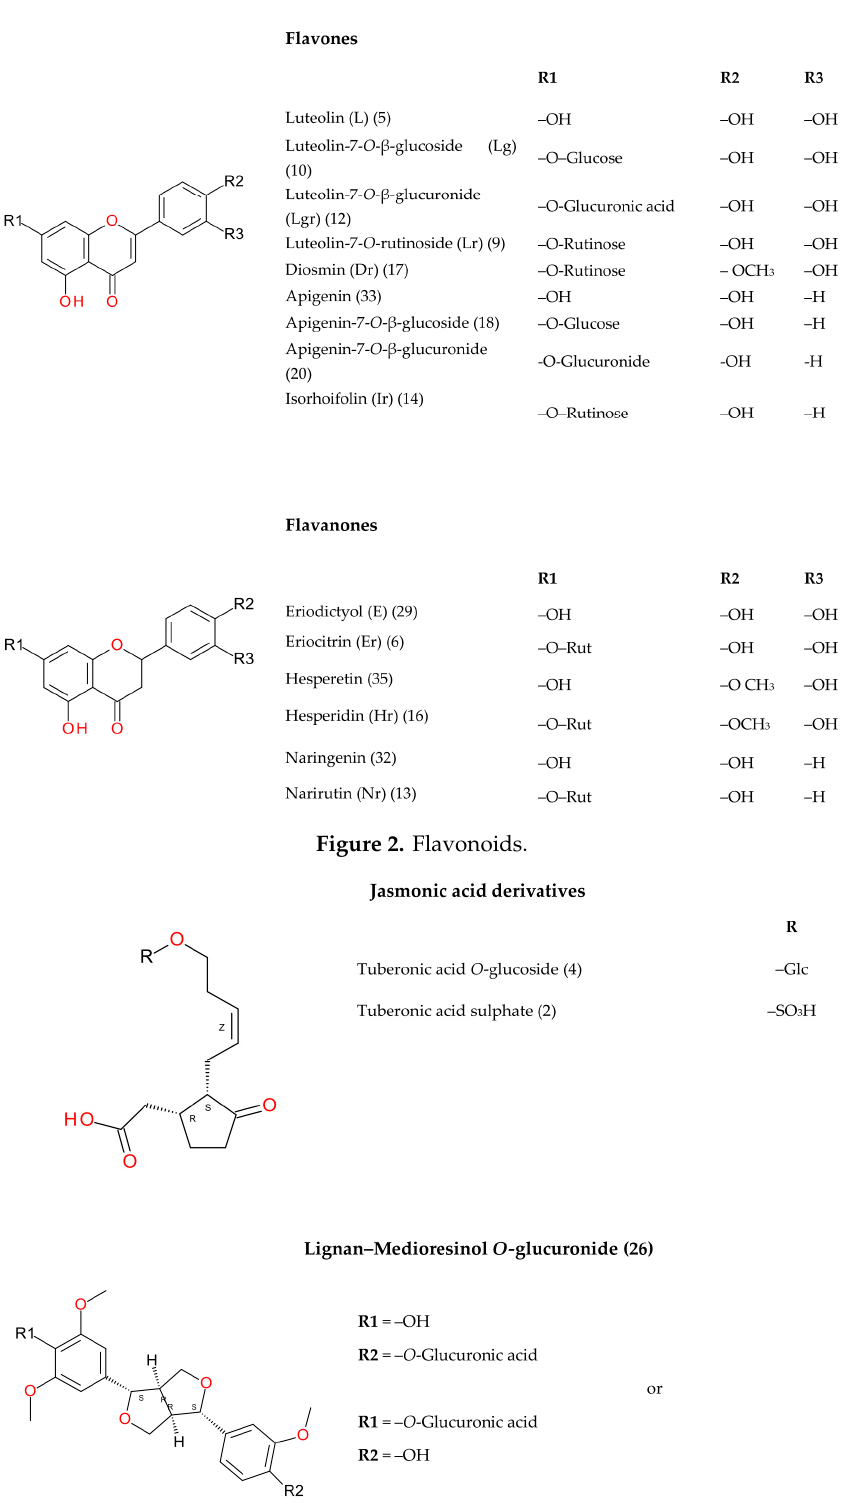
Figure 2. Flavonoids.